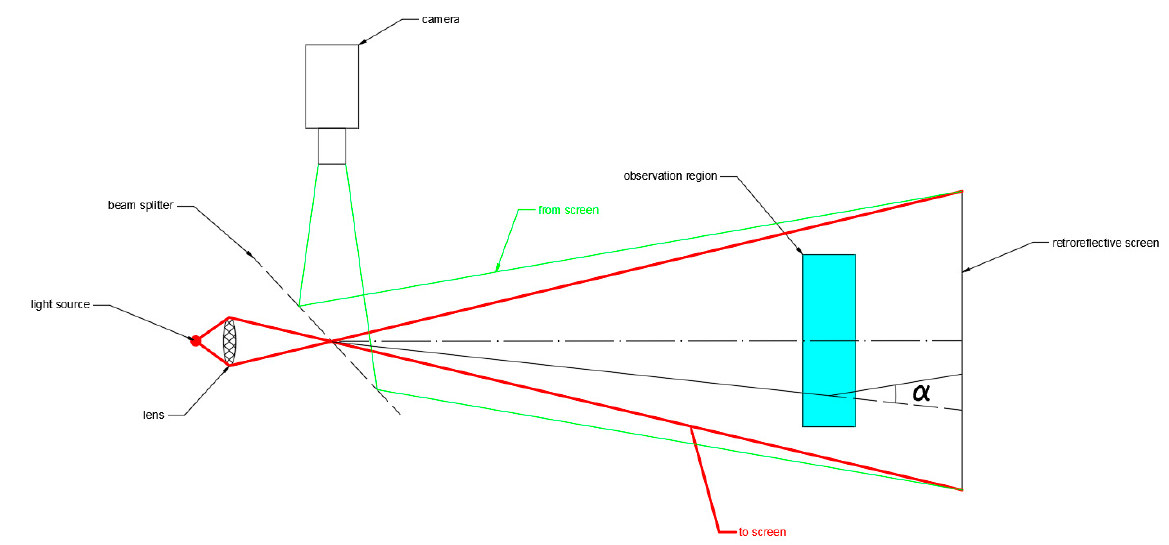
Figure 14. Retroreflective shadowgraph layout.